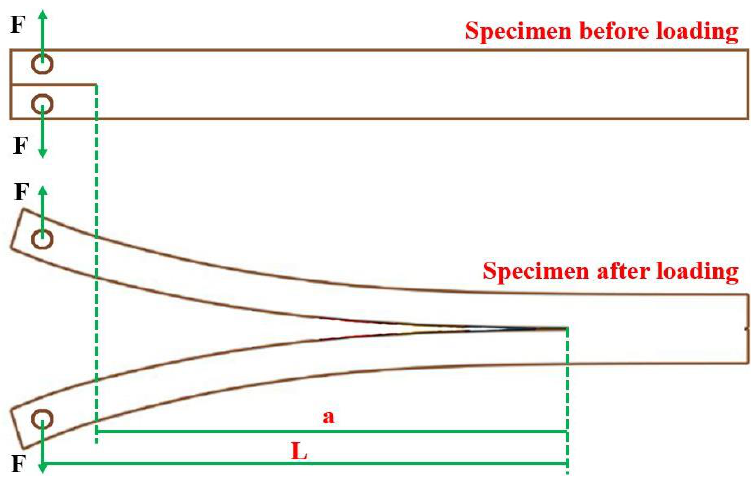
Figure 6. The difference between a and L. F.P.S.: F is external load. Figure 6. The di ff erence between a and L. F.P.S.: F is external